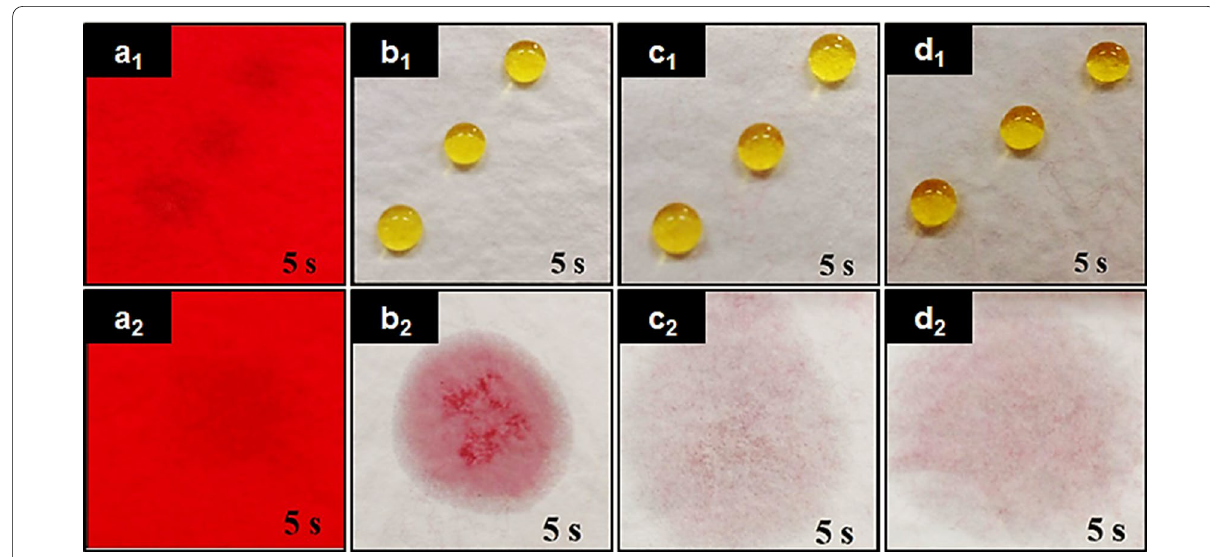
Fig. 12 Illustration of the chemical resistance of sample after removing the top layer fabric-control fabric a PAN-nonwoven; b PAN-aerogel nonwoven (2.0%); c and PAN-aerogel nonwoven (4.0%) fabrics ( d ). NaOH solution for high surface tension, represented by a 1 , b 1 , c 1 , d 1 , respectively. Methanol for low surface tension, represented by a 2 , b 2 , c 2 , d 2 , respectively [22] Copyright 2020